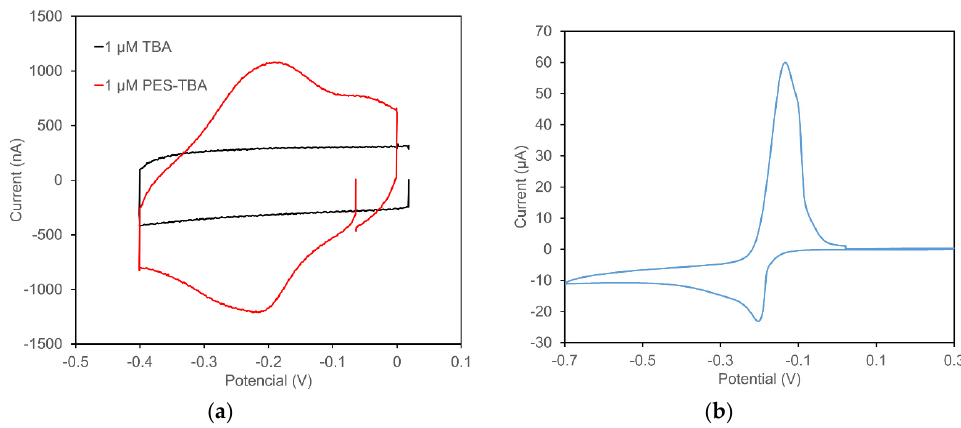
Figure 1. Cyclic voltammograms of thrombin binding aptamer (TBA) with or without modification by amine-reactive phenazine ethosulfate (arPES) ( a ), cyclic voltammogram of free methoxy-PES (mPES). ( b ) Cyclic voltammetry measurements were performed in 5 mL of PBS buffer (pH 7.4) in the presence of 1 µM TBA or PES modified ( a ) or 1 mM mPES ( b ), respectively. Scan rate was 600 mV/s ( a ), or 20 mV/s ( b ), respectively.